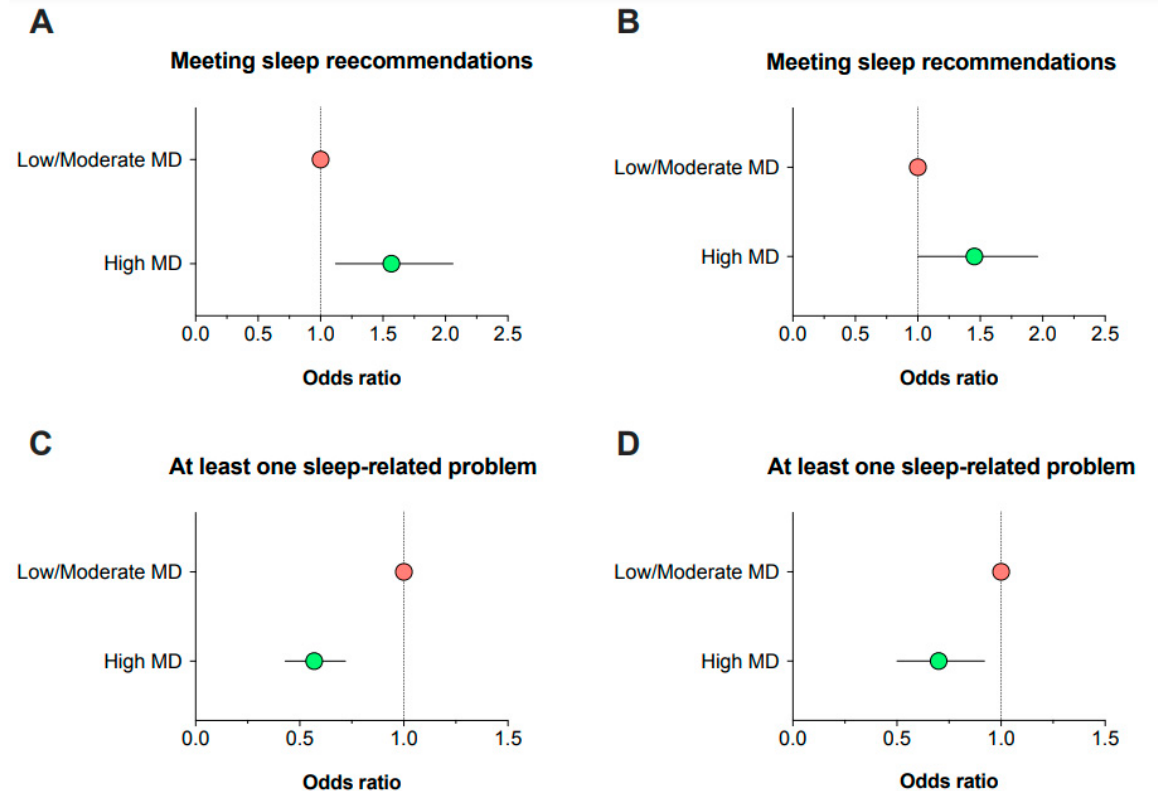
Figure 1. Odds ratio of meeting the sleep recommendations or reporting any sleep-related problem in relation to adherence to the Mediterranean diet. Data are expressed as dots (odds ratio) and lines (95% confidence intervals). ( A ): unadjusted; ( B ): adjusted for sex, age, socioeconomic status, waist circumference, energy intake, physical activity, and sedentary behavior; ( C ): unadjusted; ( D ): adjusted for sex, age, socioeconomic status, waist circumference, energy intake, physical activity, and sedentary behavior.